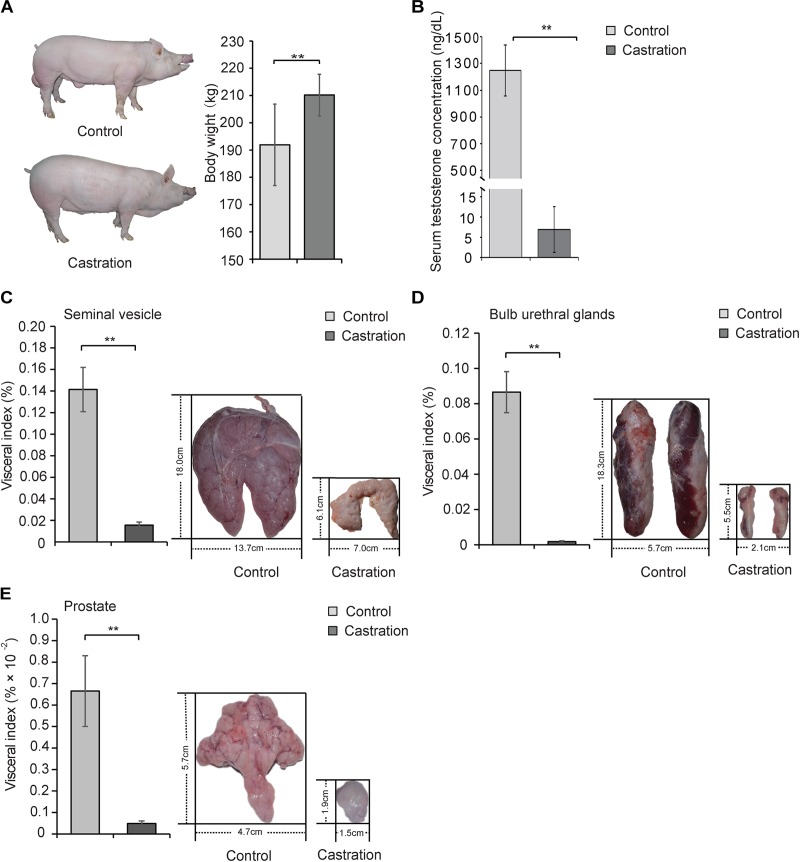
Prepubertal castration induced the decrease of serum testosterone and dysplasia of the accessory glands in adult Yorkshire boars. Castrated and control Yorkshire boars were established at 7 days old as described in Section “Materials and Methods” and the following parameters were determined in adult pigs (10 months old): (A) Body weight of control and castration. (B) Serum testosterone level and the visceral index (left panel) and size (right panel) of (C) seminal vesicle, (D) bulb urethral glands, and (E) prostate tissue. All data are expressed as means ± SD, n = 12 in each group. Student’s t-test, ∗∗P < 0.01.